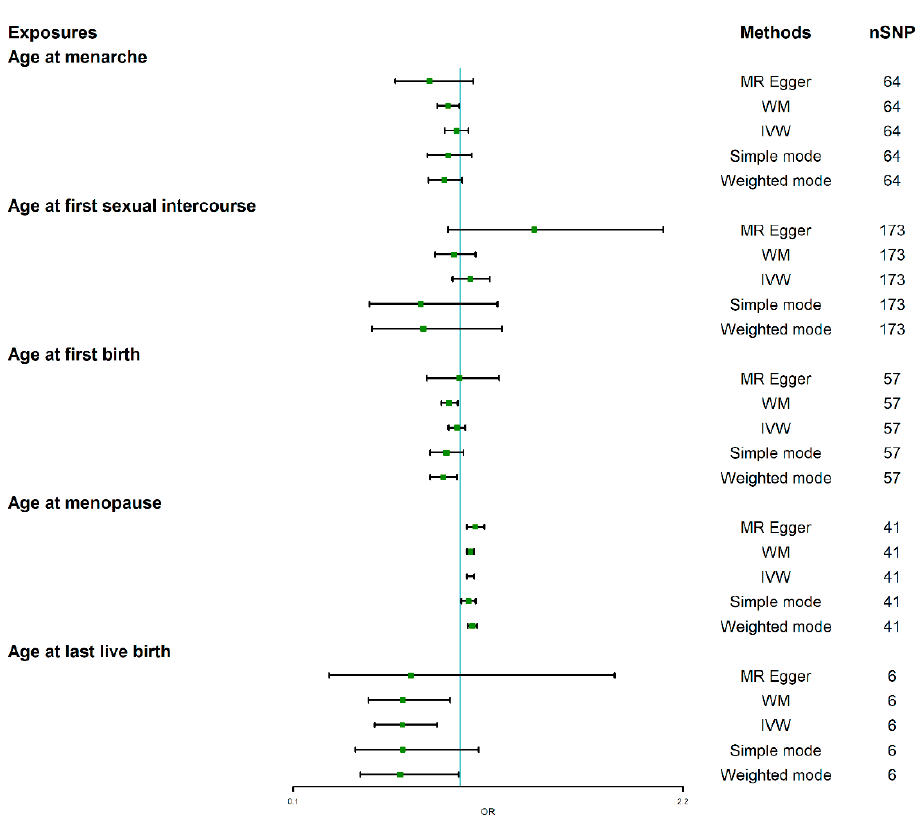
Figure 2. Forrest plot of the causal effects of five reproductive factors on BC. BC: breast cancer.